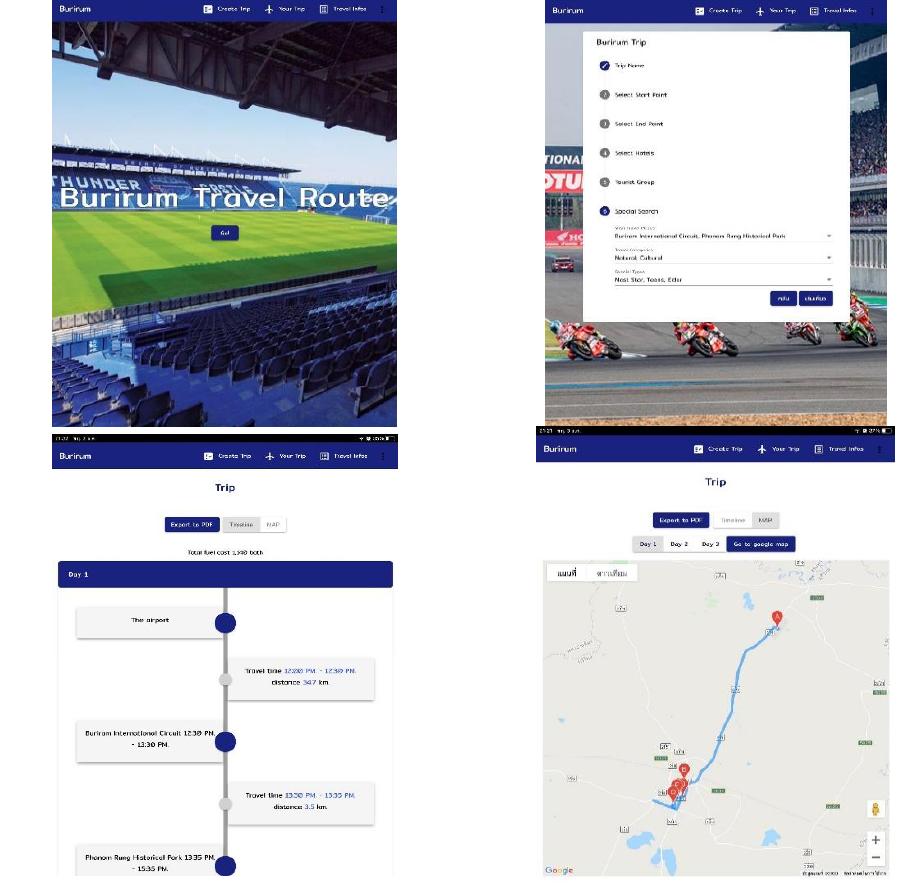
Figure 12. Example of software application model.